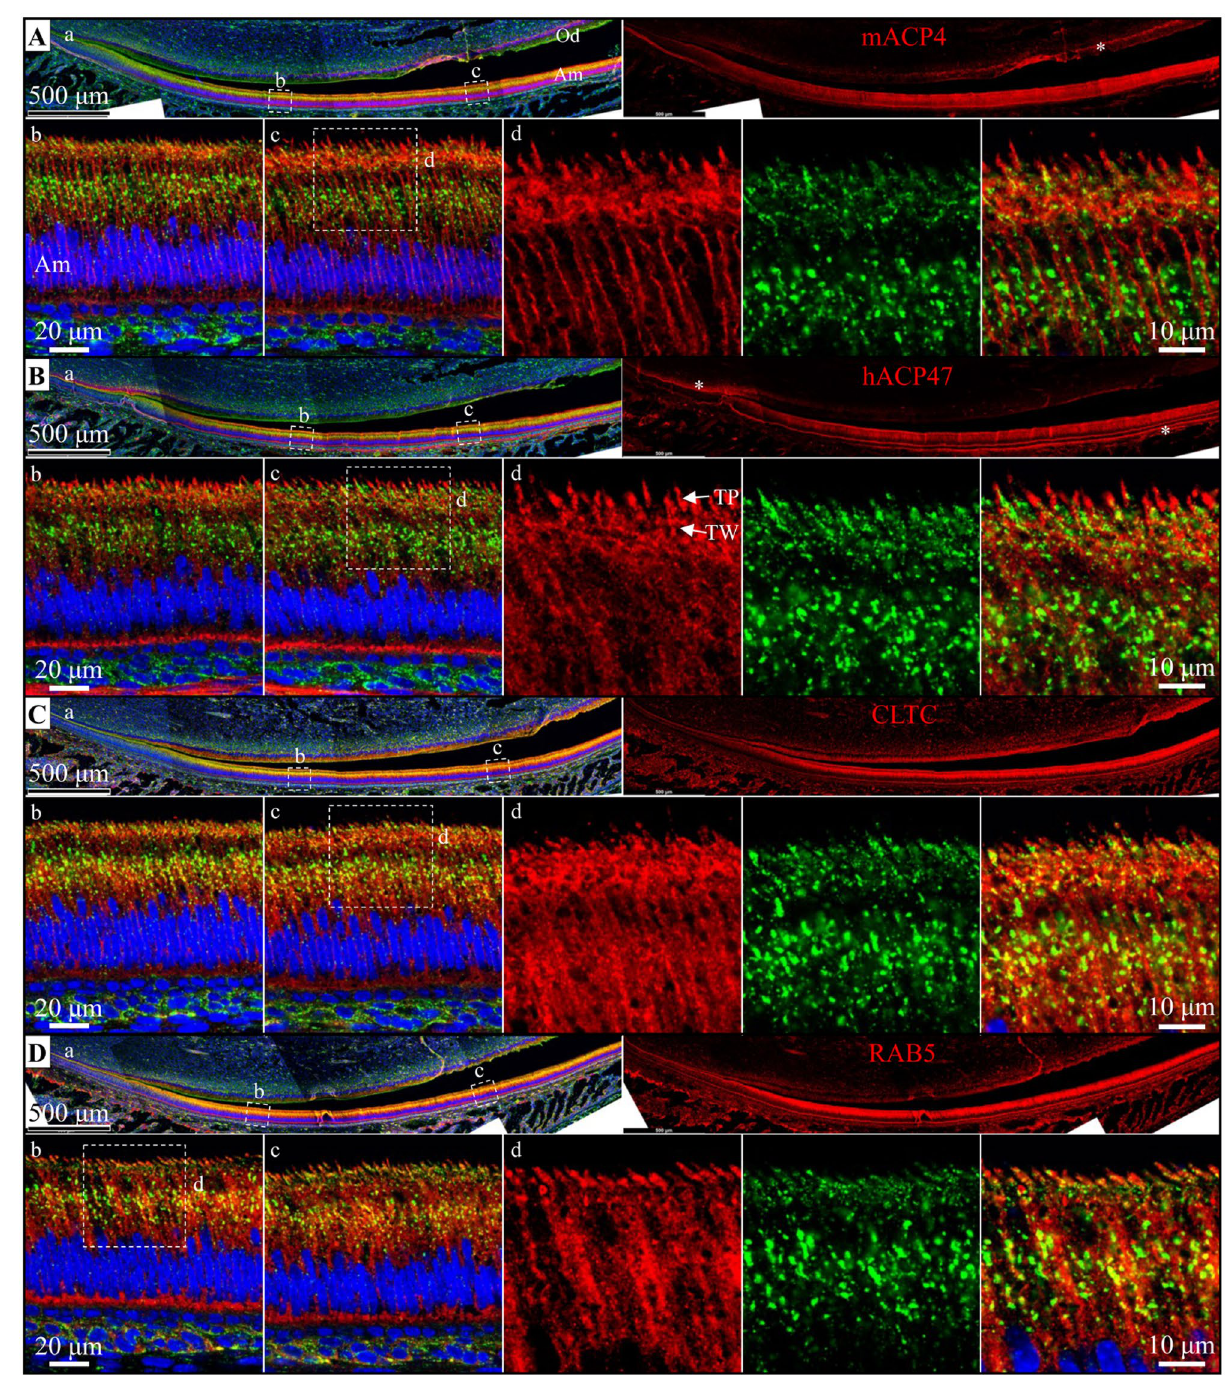
Figure 4. Immunohistochemistry of ACP4, LAMP1, CLTC, and RAB5 Expression in Consecutive, Longitudinally-Sectioned D10 Mouse Mandibular Incisors. Sections were immunostained red using antibodies against mACP4 ( A ), hACP4 ( B ), CLTC (clathrin-coated vesicles; C ), and RAB5 (early endosomes; D ) or immunostained green for LAMP1 (lysosomes and late endosomes). DAPI was used to stain cell nuclei blue. a. Tri-stained (left) and individual antibody-stained (right) apical half of mandibular incisors with box outlines of regions shown in higher magnification in b and c); b. Early and c. Mid-secretory stage ameloblasts. d. Three higher magnification images of the distal region of secretory stage ameloblasts (outlined in b or c) and immunostained for the target protein (red, left), LAMP1 (green, middle); or tri-stained (right). Am, ameloblasts; Od, odontoblasts; TP, Tomes’ processes; TW, terminal web. ACP4 and LAMP1 signals were minimally overlapping suggesting ACP4 is not a lysosomal enzyme. ACP4 localizes to the Tomes’ processes distally (potentially in endosomes and/or the distal membrane) as well as in the ameloblast lateral plasma membrane. These results are consistent with ACP4 dephosphorylating enamel matrix proteins in the matrix near the plasma membrane and in early endosomes. More immunostaining is shown in Supplemental Figs.